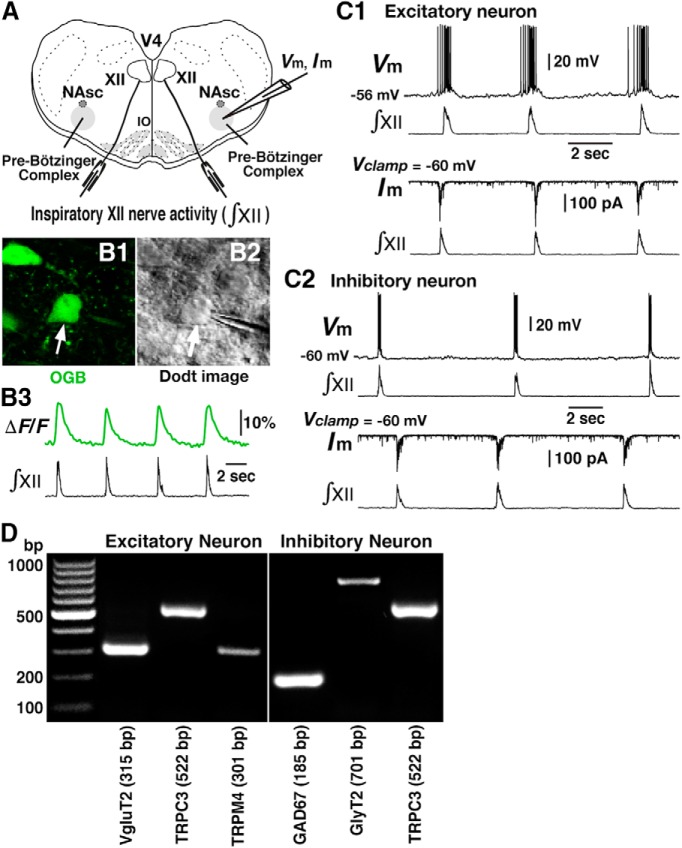
Expression of TRPM4 and TRPC3 channel mRNA in glutamatergic and glycinergic/GABAergic pre-BötC inspiratory neurons. A, Overview of experimental in vitro neonatal rat rhythmic slice preparation showing whole-cell patch-clamp recording from the pre-BötC inspiratory neurons and suction electrode recordings from hypoglossal (XII) nerves to monitor inspiratory activity. NAsc, semicompact division of nucleus ambiguus; V4, fourth ventricle. B, Two-photon single optical plane images of pre-BötC inspiratory neuron (arrow) targeted for whole-cell recording and subsequent harvesting of cytoplasm, showing Ca2+-sensitive dye (OGB) labeling (B1) and Dodt structural image (B2). B3, Identification of inspiratory neuron by verifying that the Ca2+ fluorescence signals in real time are synchronized with integrated inspiratory XII nerve activity (∫ XII). C1, Current-clamp recording (upper traces) from excitatory pre-BötC inspiratory neuron in Billustrates inspiratory bursts synchronized with ∫ XII. Under voltage-clamp (lower traces), the same neuron exhibited rhythmic inward synaptic currents synchronized with ∫ XII. This neuron was shown to be excitatory (VgluT2-expressing) by post hoc single-cell RT-PCR (below). C2, Current-clamp recording (upper traces) and voltage-clamp recording (lower traces) from inhibitory pre-BötC inspiratory neuron illustrating inspiratory bursts and rhythmic inward synaptic currents synchronized with ∫ XII. This neuron was shown to be inhibitory (co-expression of GlyT2 and GAD67 mRNA) by post hoc single-cell RT-PCR (see below). D, Representative electrophoresis gel generated by single-cell multiplex RT-PCR from mRNA in cytoplasm harvested during whole-cell recording from two electrophysiologically identified pre-BötC inspiratory neurons (C1 and C2) in neonatal rat slices. In addition to cDNA probes for TRPM4 and TRPC3 channel mRNA, probes for vesicular glutamate transporter type 2 (VgluT2), glycine transporter type 2 (GlyT2), and glutamatic acid decarboxylase 67 (GAD67) mRNA were used to identify excitatory or inhibitory neuronal phenotypes, examples of which are shown. Expected numbers of base pairs (bp) for reaction products are indicated. Assays for both of these neurons had clean negative controls from “mock harvests” in the slice and appropriate positive controls from 100 pg total rat brain RNA run as RT template (not shown, see Materials and Methods).